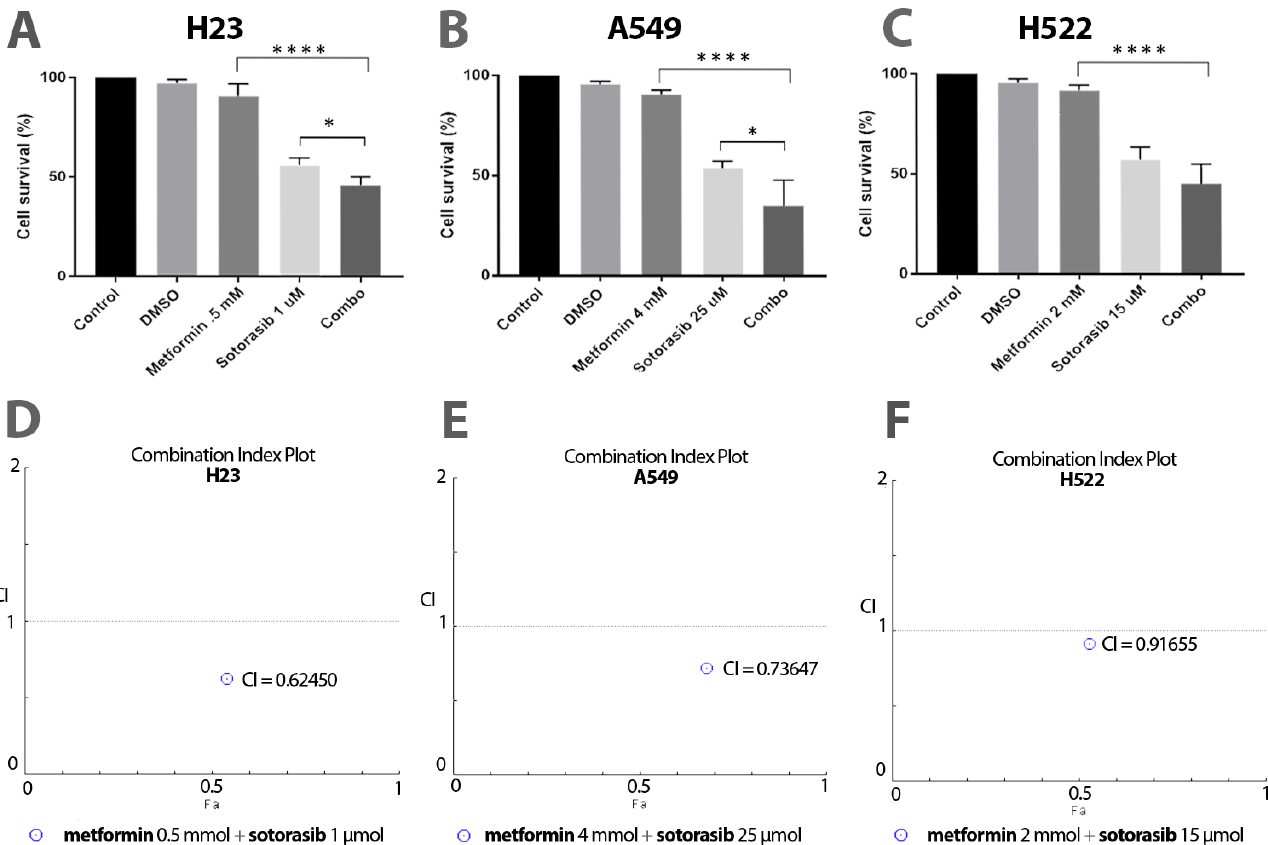
Figure 1. Cytotoxic effect of sotorasib and metformin as single agents or in combination. ( A – C ), MTT assays were performed to evaluate the cytotoxicity of these treatments. Each bar represents a mean of 3 independent experiments, and these drugs are tested in triplicate in each one. Two-way ANOVA was carried out to identify statistical differences among groups, indicated here as * p ≤ 0.05, **** p ≤ 0.0001. ( D – F ) combination index plots exhibited synergistic effects of combining metformin and sotorasib in all cells, described as points below 1 (threshold).